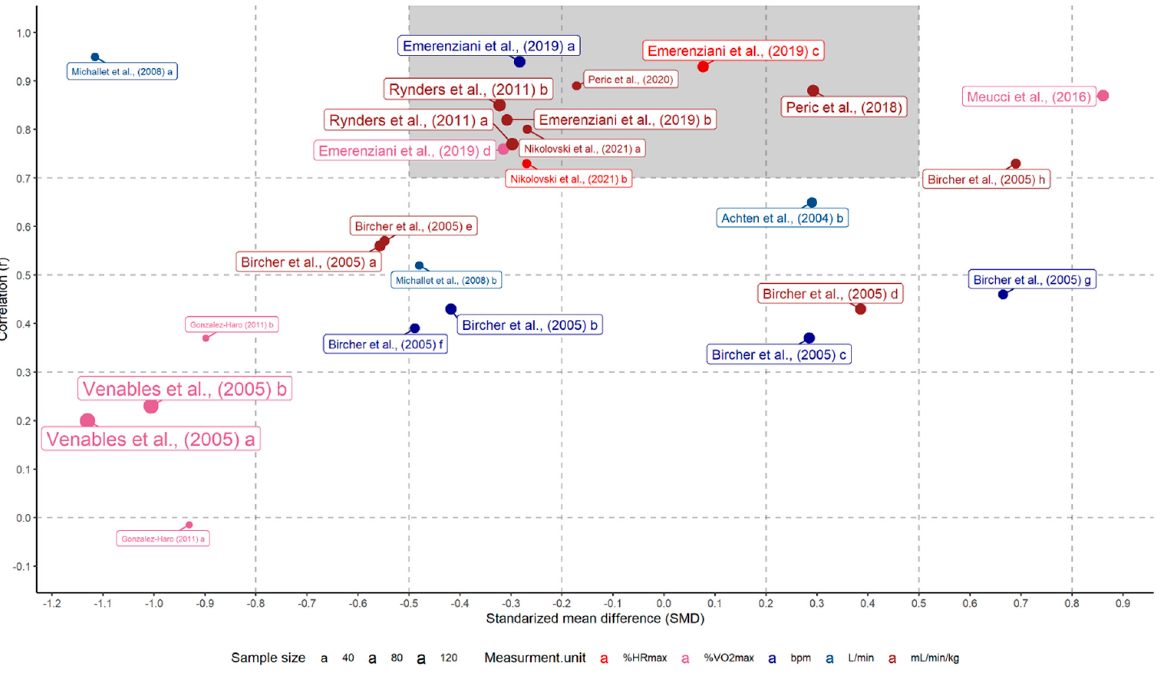
Figure 4. Correlation coefficients vs. SMD plot for exercise intensities methods, categorized by measurement units. NOTE : Bluish colors are used for display of potentially non-spurious measurement units, (i.e., bpm and L/min), and the reddish colors are used for display of potentially spurious measurement units, (i.e., %HR max , %VO 2max , and mL/min/kg), respectively [12,18–22,49,52–55].